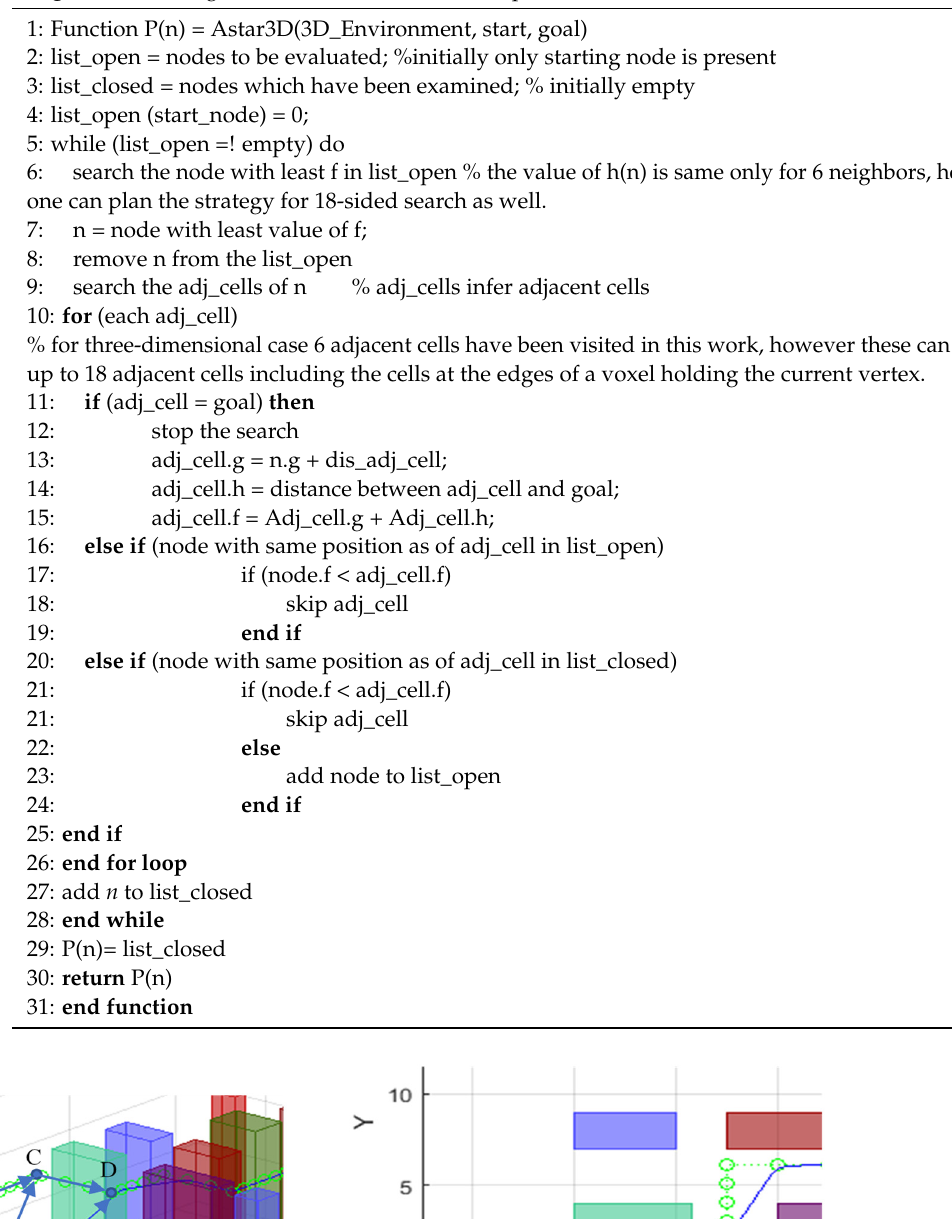
Algorithm 1 A* algorithm for three-dimensional path search (with 6-sided search).